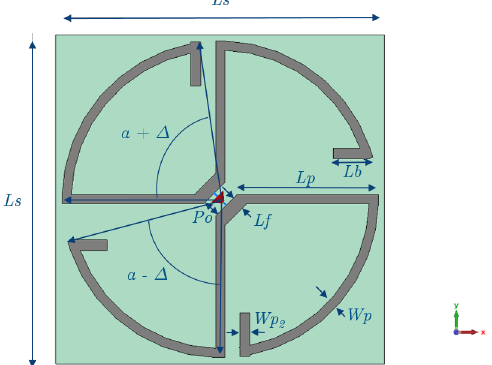
Figure 3. Proposed Planar Crossed Dipoles for isotropic radiation.